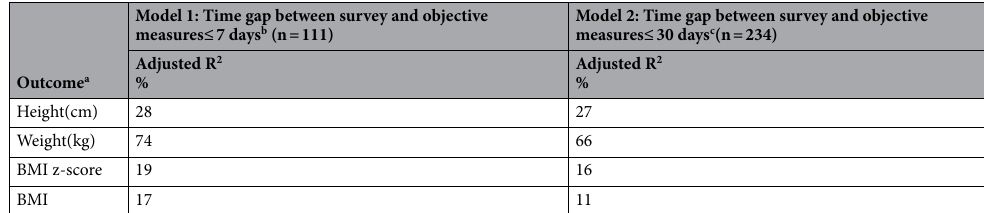
Model 2 (time gap between the reported and measured within 30 days):